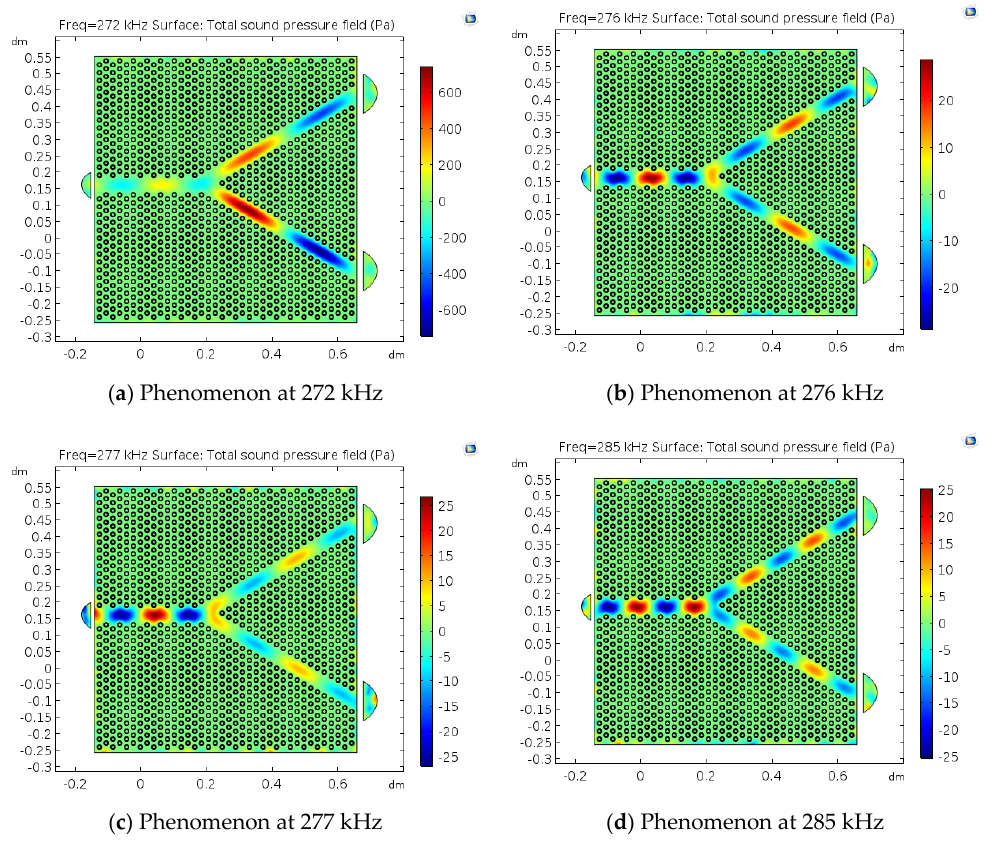
Figure 4. Sound wave transmission effect at different frequencies: ( a ) Phenomenon at 272 kHz; ( b ) phenomenon at 276 kHz; ( c ) phenomenon at 277 kHz; ( d ) phenomenon at 285 kHz.